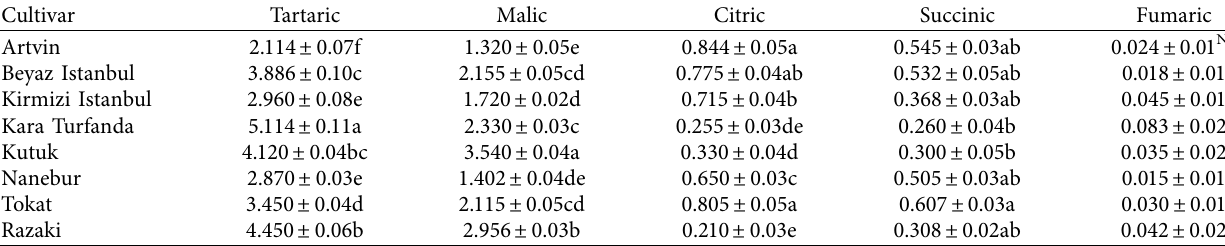
Table 4: Organic acid content in berries of grape cultivars